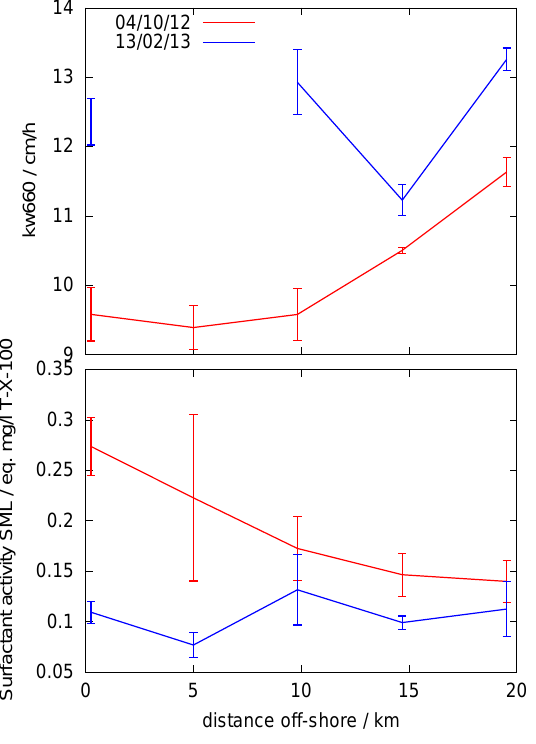
Figure 10. Top: estimated transfer velocities of seawater samples scaled to Schmidt number 660 for two transects in the coastal North Sea off northeast England. Bottom: measured surfactant activity (SA) of the surface microlayer (SML) on transects in the coastal North Sea off northeast England. Results are expressed as equiva- lent concentration of the calibration surfactant Triton T-X-100.